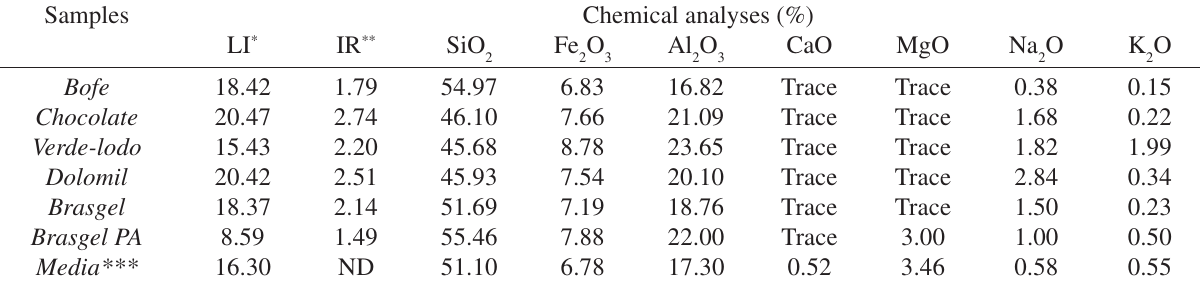
Table 3. Chemical composition of the natural and industrialized bentonites.